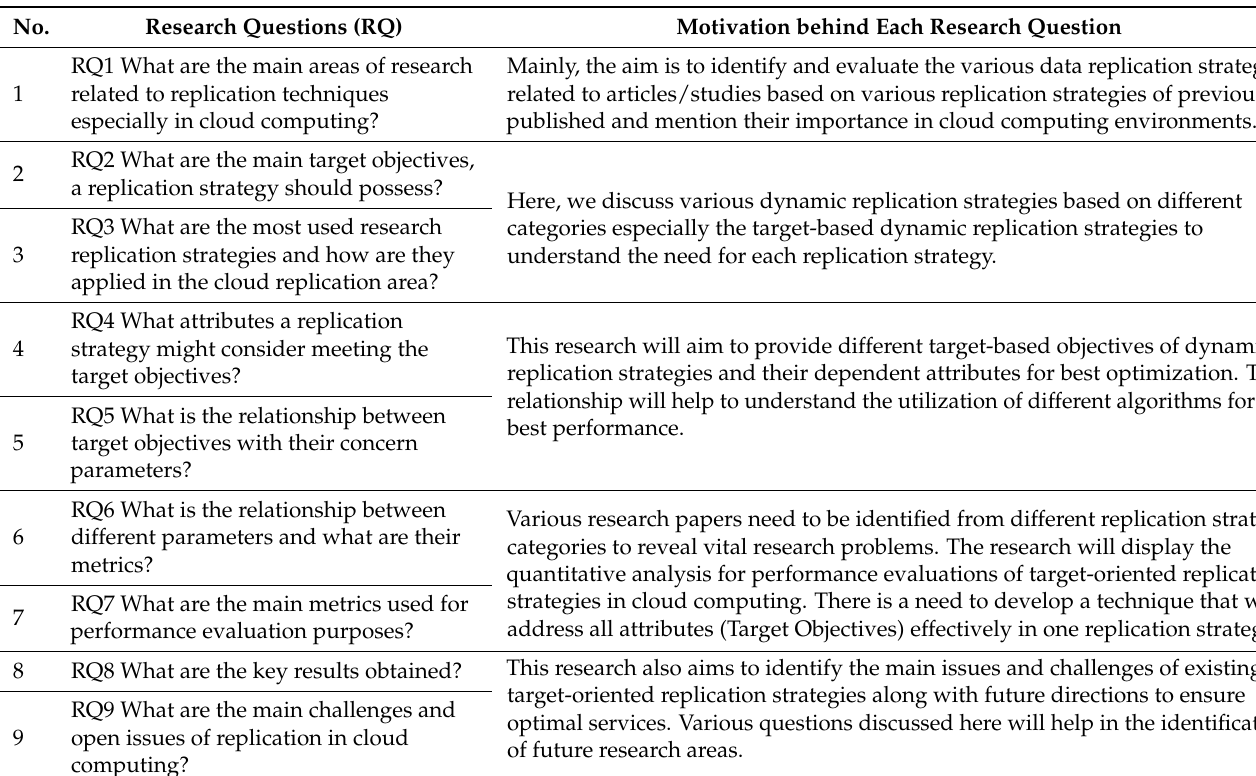
Table 1. Research